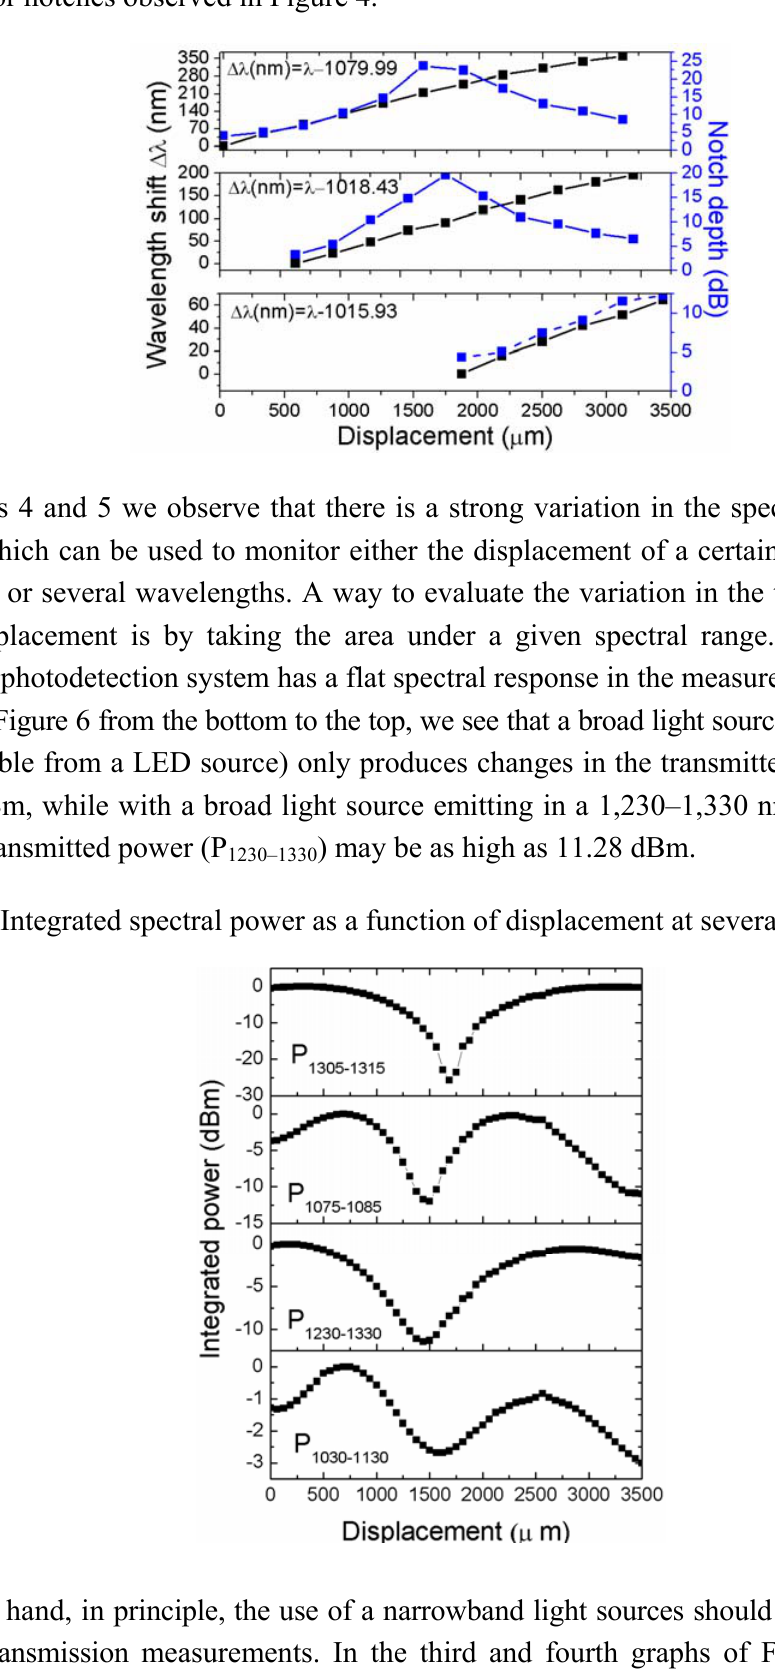
Figure 5. Spectral shift and notch depth as a function of displacement distance for the three major notches observed in Figure 4.